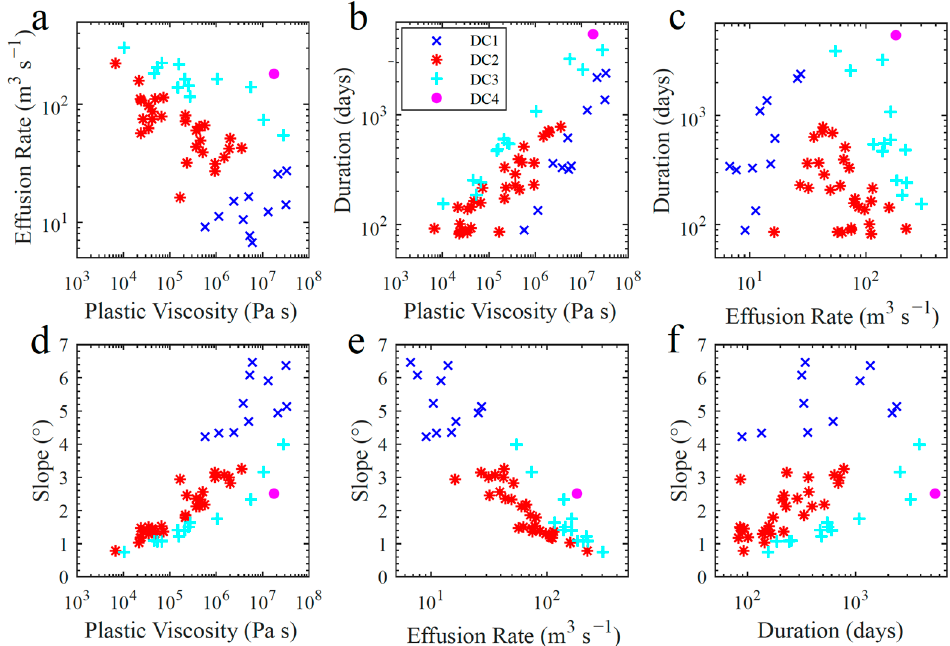
Figure 7. Graphs showing the variation of ( a ) effusion rate vs. plastic viscosity, ( b ) duration vs. plastic viscosity, ( c ) duration vs. effusion rate, ( d ) average flank slope vs. plastic viscosity, ( e ) average flank slope vs. effusion rate, and ( f ) average flank slope vs. duration of 54 domes in both the Gardner volcano and the northern Mare Tranquillitatis, colored with respect to the assigned dome cluster (DC1 to